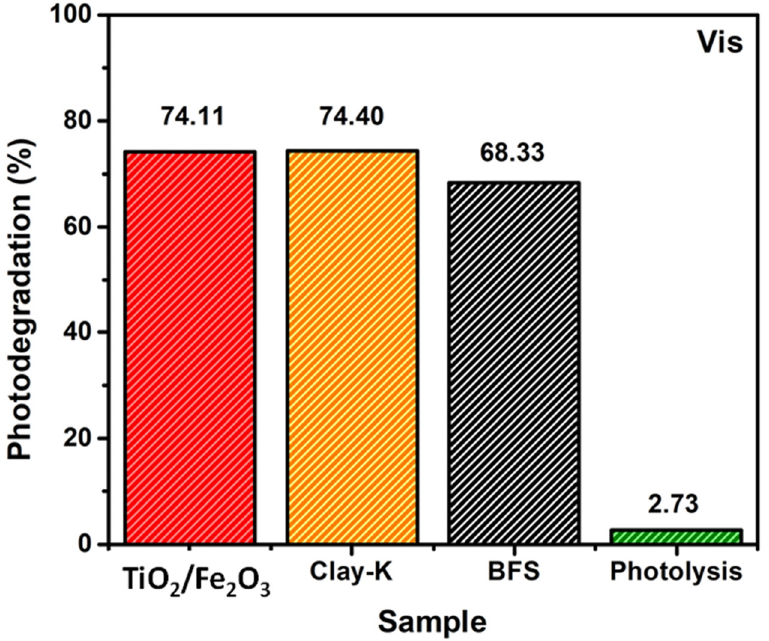
Figure 11. Percentages of cyanide photodegradation with Clay-K, BFS, and Fe 2 O 3 /TiO 2 materials using irradiation with visible light for 2 h. Initial concentration of NaCN of 750 mg/L.